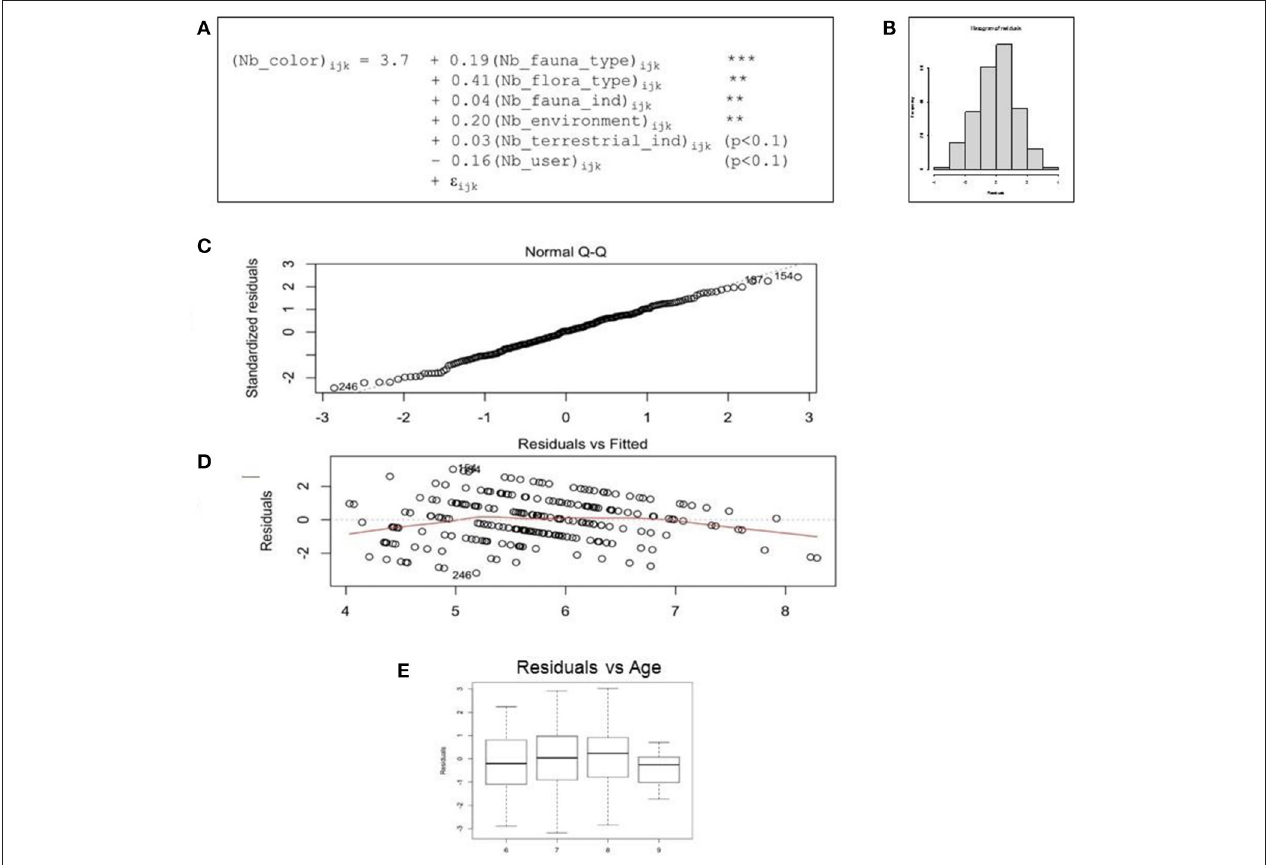
FIGURE 5 | Validation of the multiple regression model established between the number of colors and 14 quantitative variables describing the drawings ( Table 3 without number of marine phenotype). (A) regression model used with the most significant variables (*** p < 0.001, ** p < 0.01, and 0.05 < p < 0.1), (B) histogram of residuals, (C) quantile-quantile plot of the standardized residuals, (D) standardized residuals vs. fitted values, (E) box plot of standardized residuals vs. children’s age.